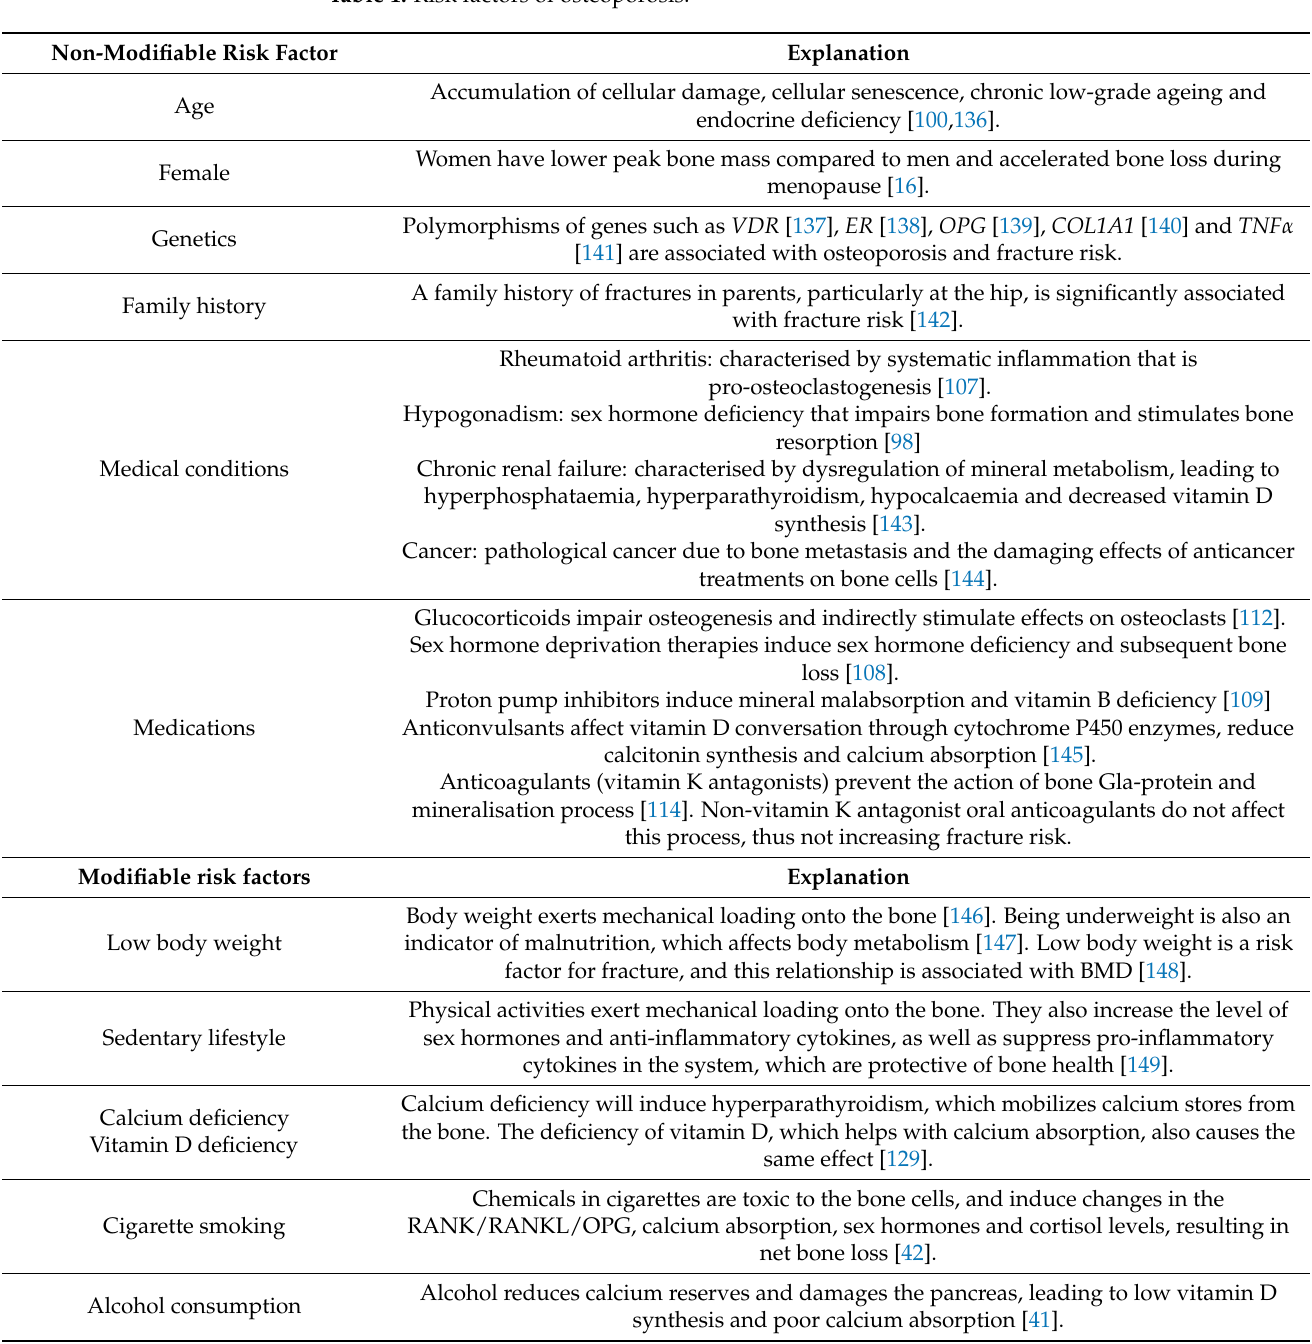
Table 1. Risk factors of